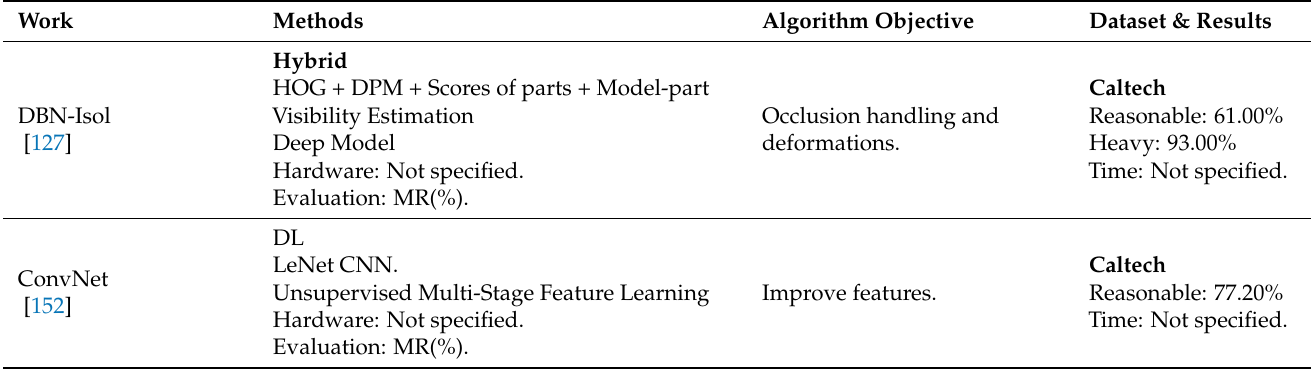
Table 6. Relevant works for pedestrian detection using hybrid or DL techniques. Algorithm